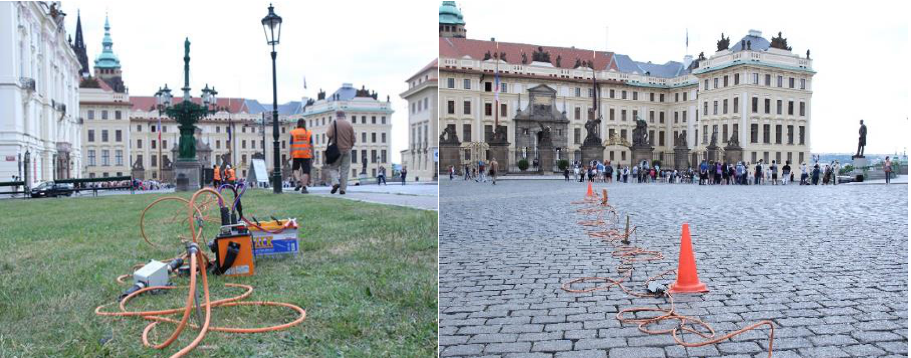
Figure 13. Hradčany Square. Geoelectrical system ARES II and electrodes on the profile. Figure 13. Hradˇcany Square. Geoelectrical system ARES II and electrodes on the